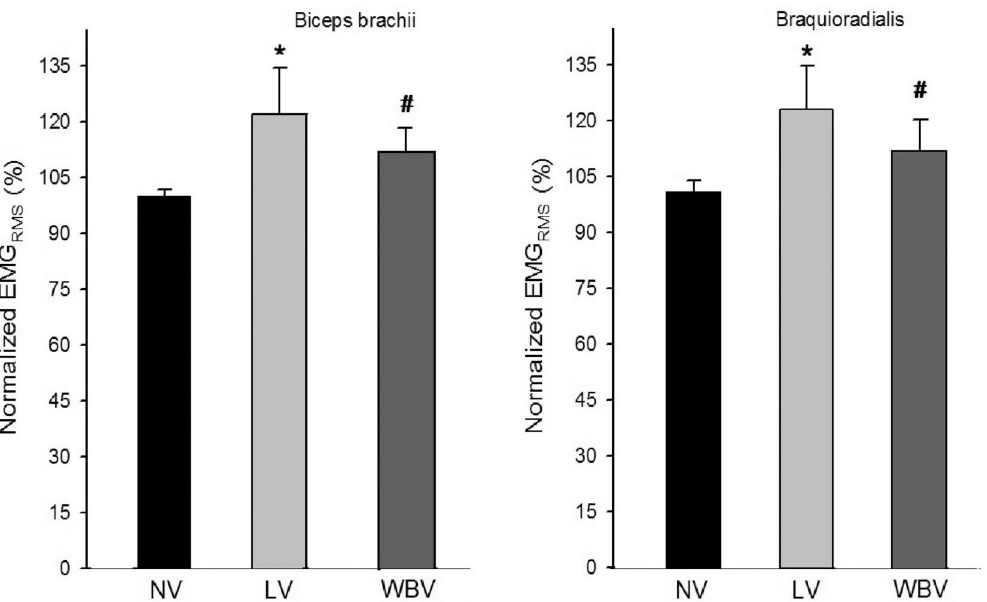
Figure 4 - Normalized EMG RMS of the biceps brachii and brachioradialis during the MVIC. MVIC = maximum voluntary isometric contraction. NV = No vibration; LV = Local Vibration; WBV = whole-body vibration. Vertical lines = standard errors. *: Greater than NVand WBV. #: Greater than NV. Significance level at α < 0.05.